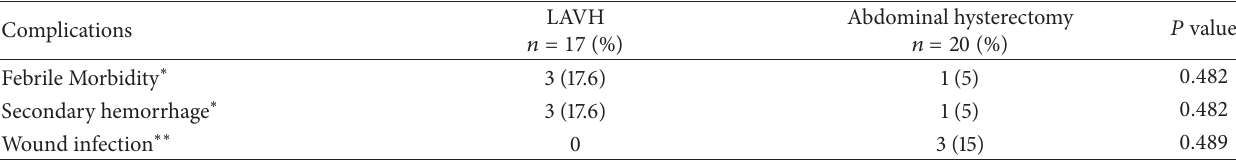
Table 3: Postoperative complications.